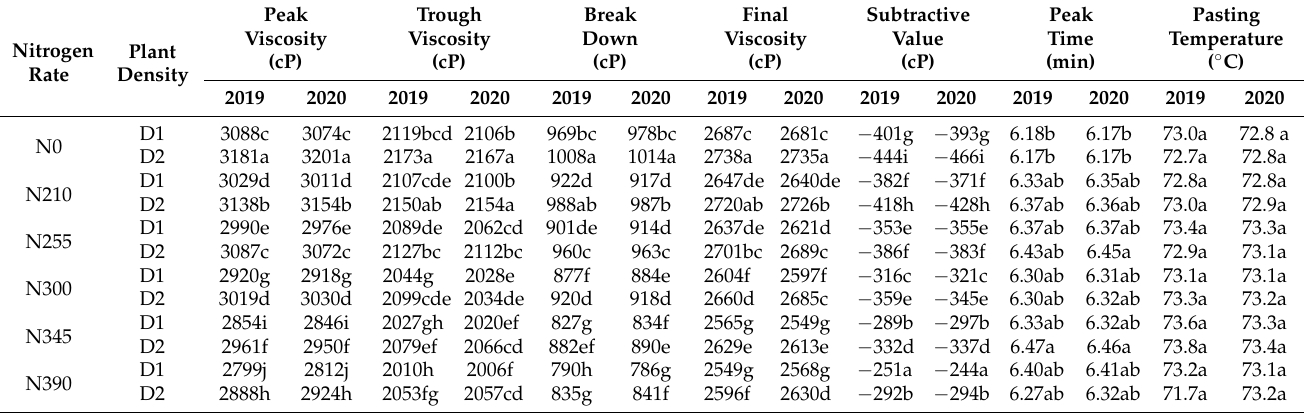
Table 9. Grain pasting quality under combined nitrogen rate and planting density in saline-alkali land.